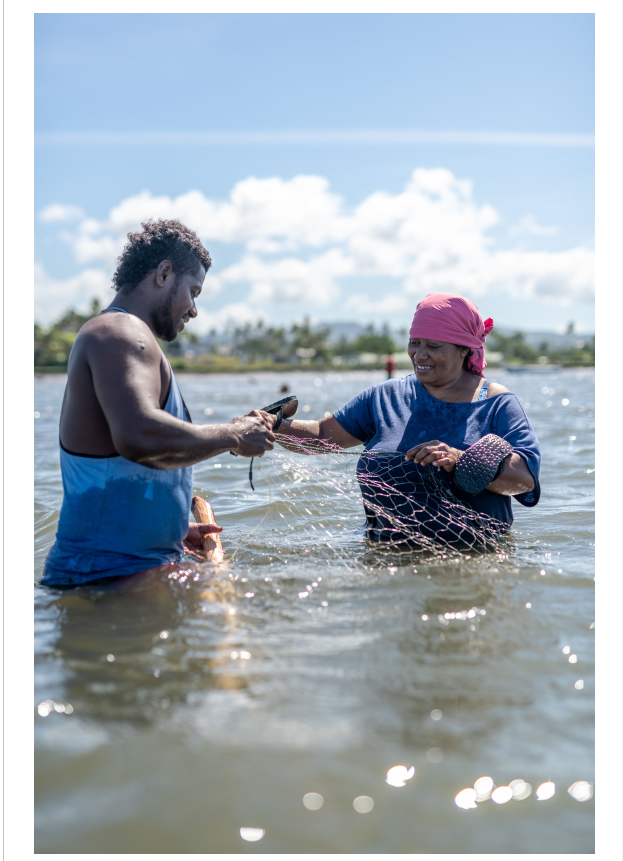
FIGURE 1 Woman and man fi shing in Fiji. Photographer: Tom Vierus, WIldlife Conservation